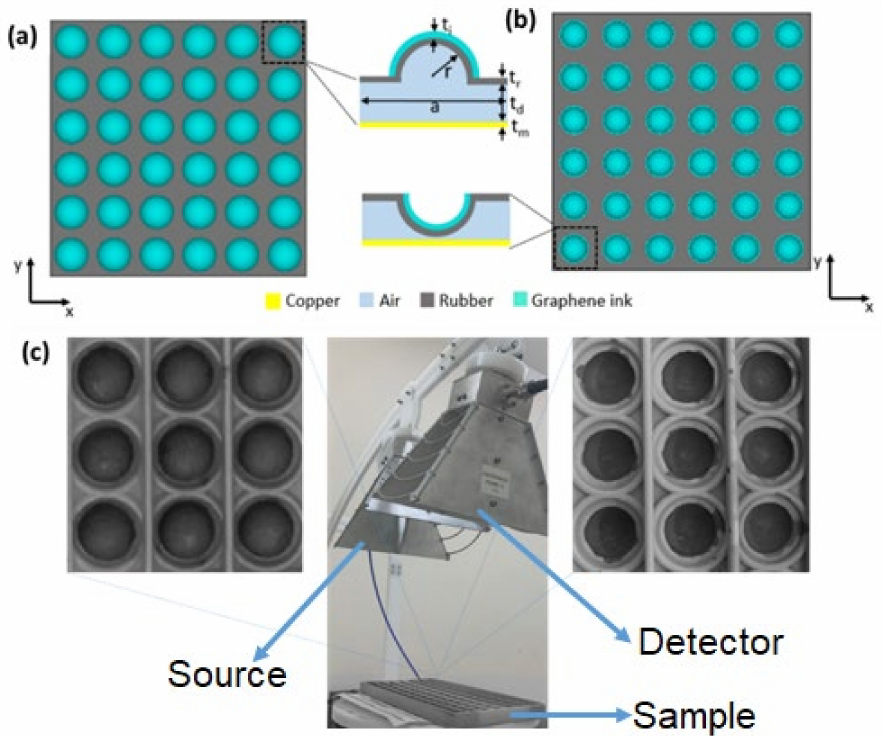
Figure 1. Schematic of the proposed MPA with all unit-cells in ( a ) CD and ( b ) CU states. ( c ) Measure- ment configuration for the proposed MPA in CD (left) and CU (right)